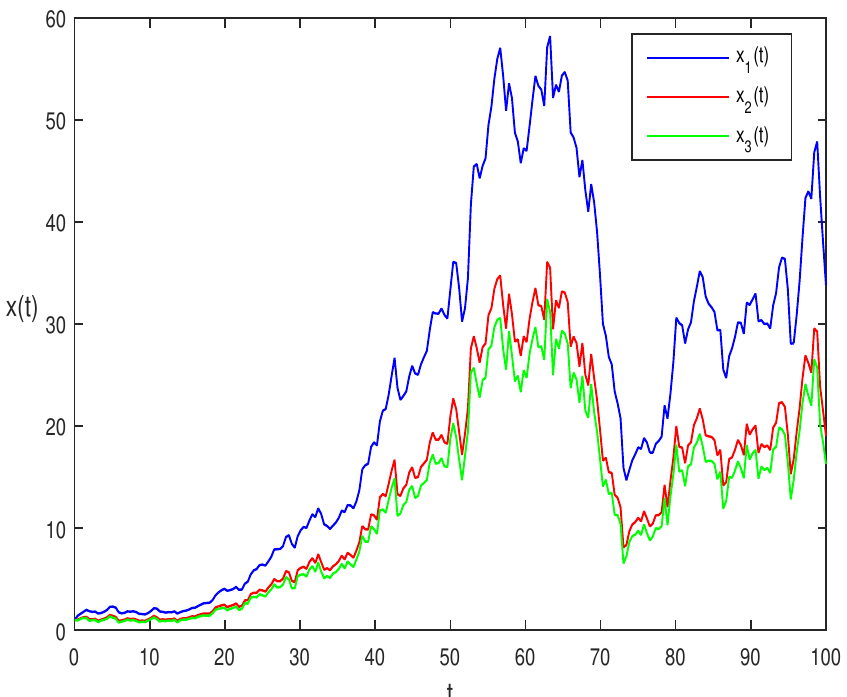
Figure 3. Solution for each class of stochastic delay NGM systems from Equation (1), with τ i = ρ i = 1 (i = 1, 2, 3).